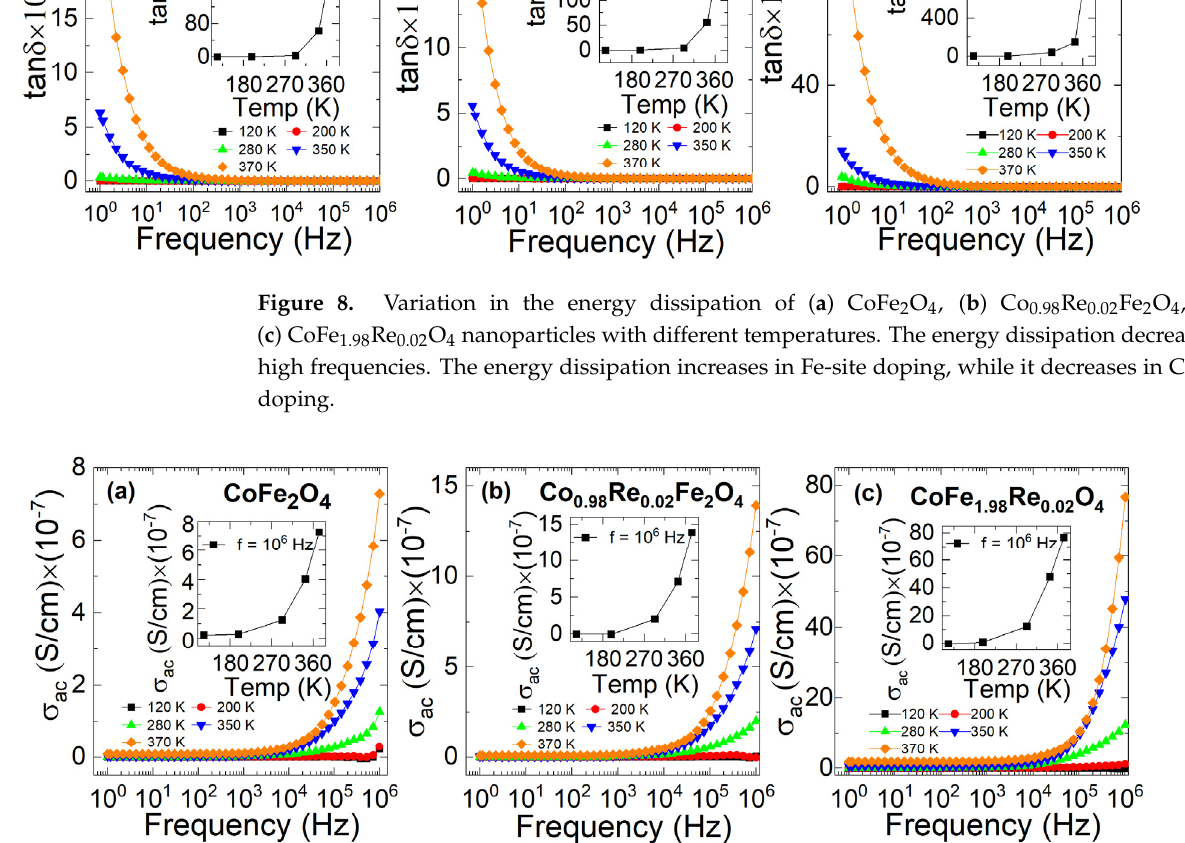
Figure 9. Variation in the AC conductivity of ( a ) CoFe 2 O 4 , ( b ) Co 0 . 98 Re 0 . 02 Fe 2 O 4 , and ( c ) CoFe 1 . 98 Re 0 . 02 O 4 nanoparticles with different temperatures. The AC conductivity increases at high frequencies. The AC conductivity increases in both Fe-site doping and Co-site doping.